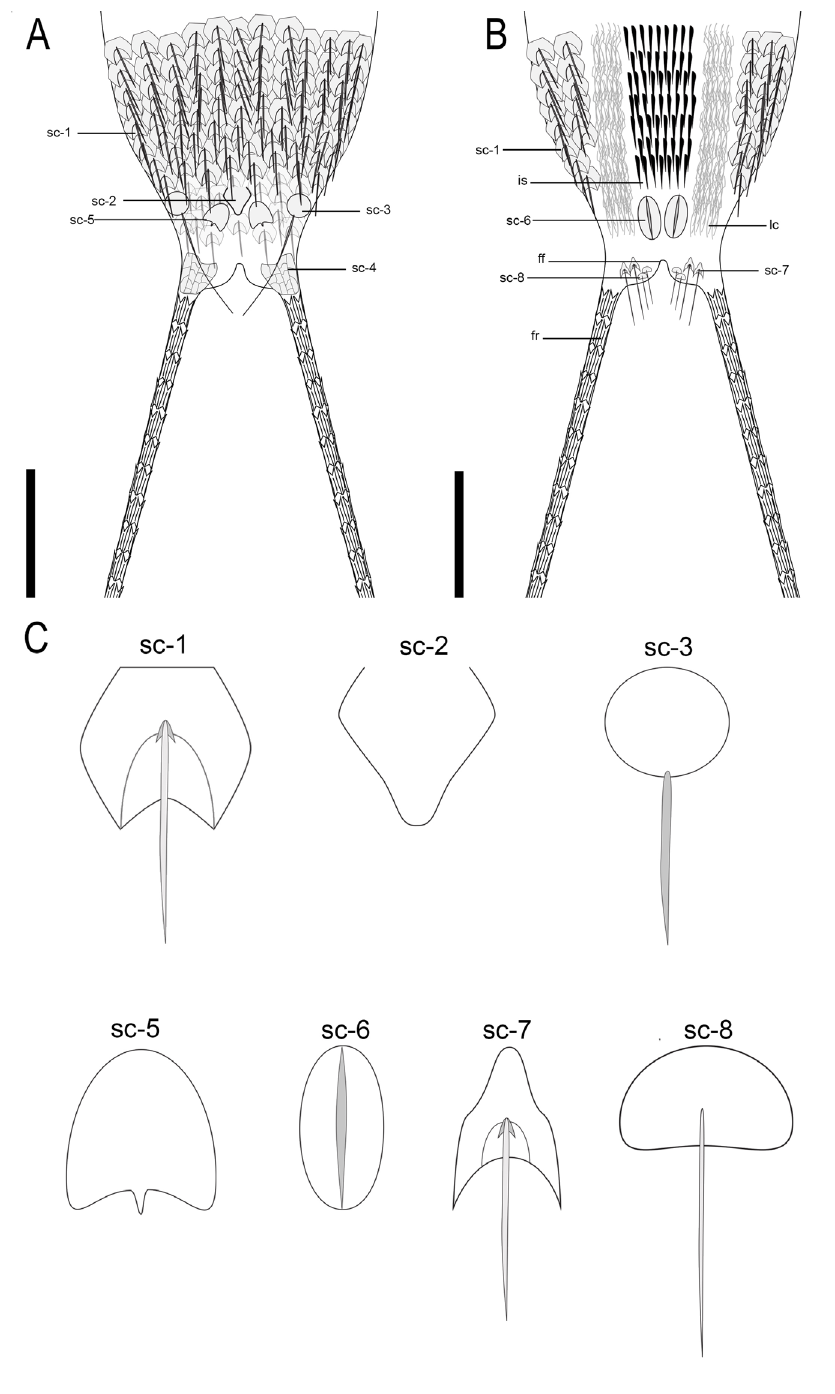
Fig. 6. Schematic illustration of dorsal and ventral posterior regions and type scales of Polymerurus insularis sp. nov. A–B . Paratype (ZUEC GCH 56). A . Dorsal view of the posterior end. Some Type 1 scales are faded for a better visualization of Types 2 , 3 and 5 scales. B . Ventral view of the posterior end. C . Each type of scale, individually depicted (not to scale). Abbreviations: ff = furcal furrow; fr = furcal rami; lc = locomotory cilia; is = interciliary spines; sc-1 = Type 1 scales; sc-2 = Type 2 scale; sc-3 = Type 3 scales; sc-4 = Type 4 scales; sc-5 = Type 5 scales; sc-6 = Type 6 scales; sc-7 = Type 7 scales; sc-8 = Type 8 scales. Scale bars = 40